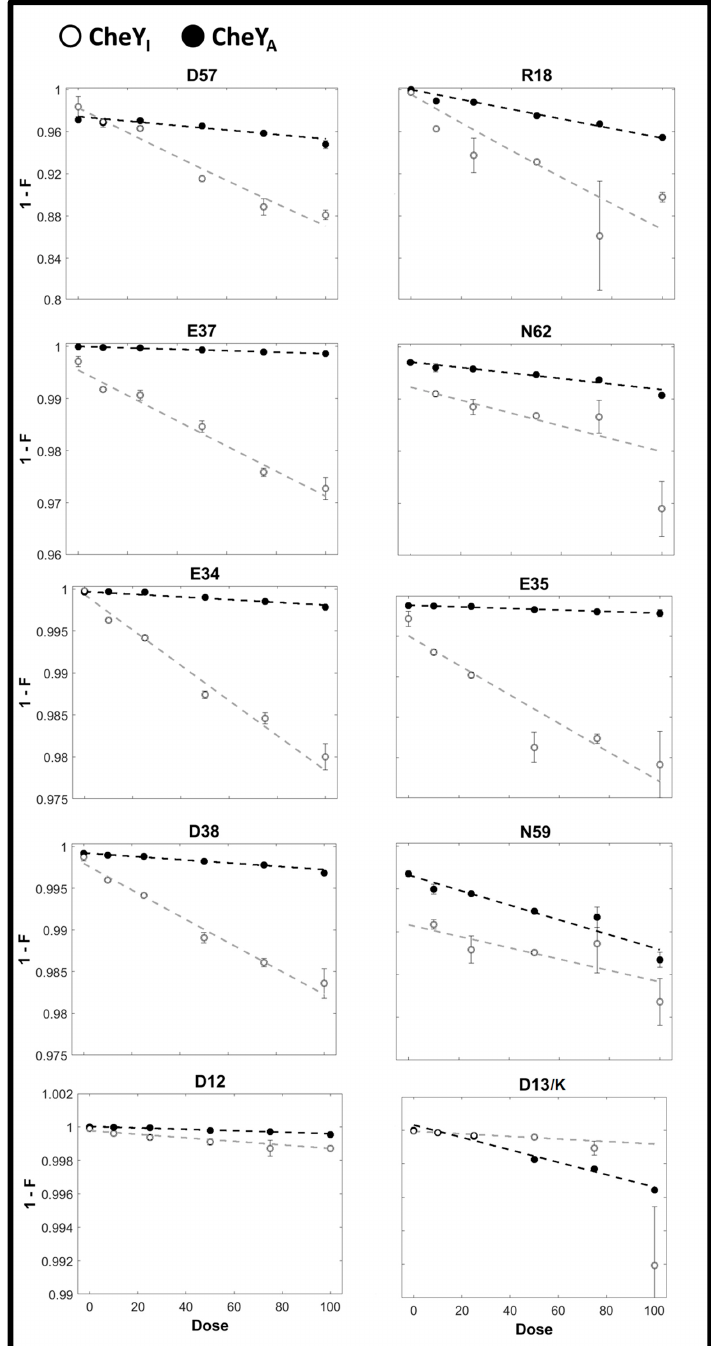
Figure 1. XFMS dose-response curves for residues around the 57D phosphorylation site. Oxidation rates were computed from the slopes of single exponential fits, weighted by reciprocal of the standard error, for all ten residues, including 57D. The CheY A rates (black dashed lines) were lower than those for CheY I (grey dashed lines) in all cases, except for 13D/K and 59N. The intrinsic reactivity to hydroxy radical oxidation is greater for K (2.2) than D